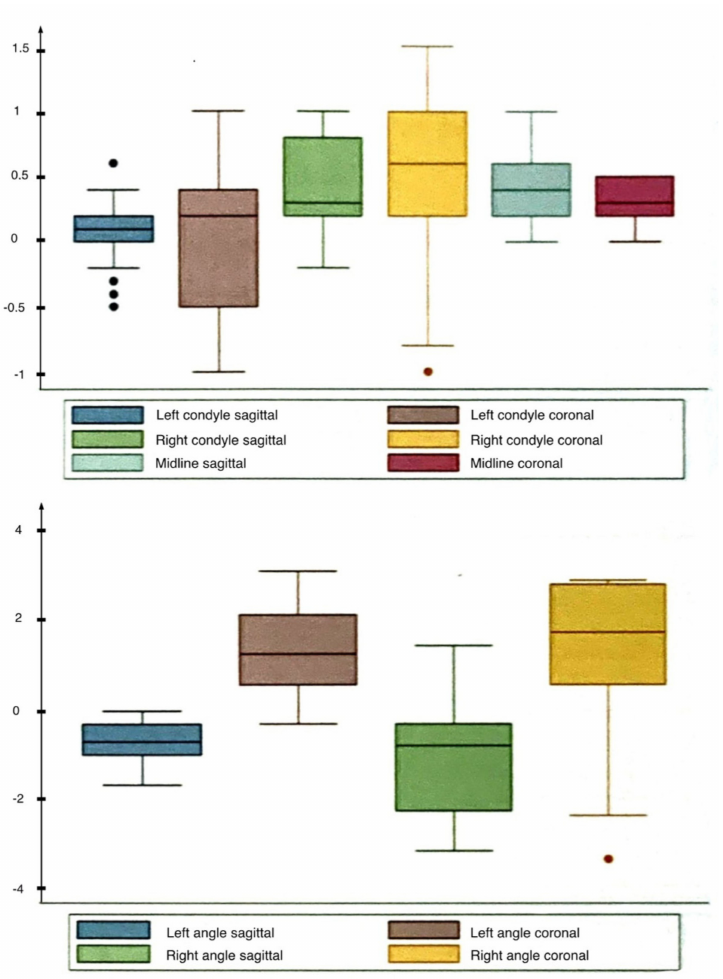
Figure 7. Landmarks box plot: the box represents the interquartile range between Q1 and Q3, the continuous line inside the box represents the median, the continuous line outside the box shows the global range of parameters distribution and the dots represent